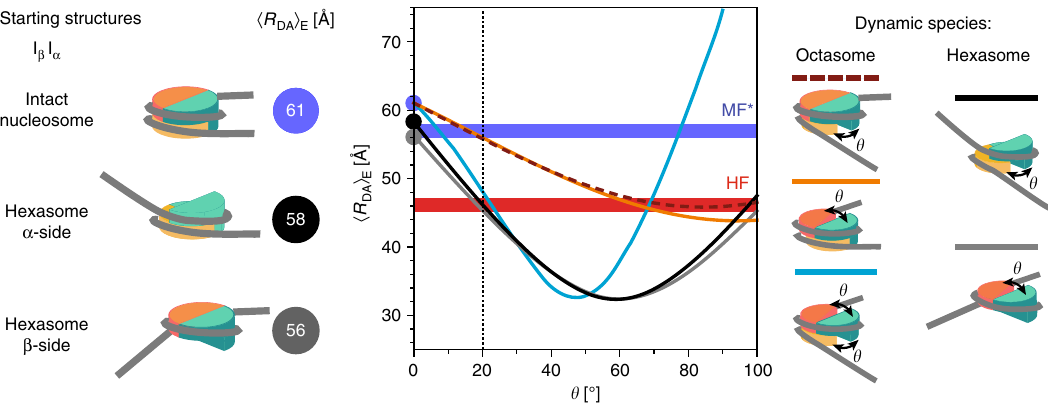
Fig. 7 A geometric model for nucleosome dynamics. All details on the parameterization of the intact nucleosome and de fi nitions of relevant parameters and the computer code are given in Supplementary Note 3. The (H3-H4) 2 tetramer is shown in turquoise, while H2A-H2B heterodimers are shown in orange ( α -side) and dark yellow ( β -side). The interdye distances 〈 R DA MF* 〉 E are computed for the following three starting structures (opening angle θ = 0°): the intact nucleosome and both possible hexasomes with an open α -side and β -side, respectively. We compute the geometry of potentially dynamic nucleosome species as a function of the opening angle θ (between the H2A-H2B dimer and the (H3-H4) 2 tetramer) for fi ve scenarios dimer:tetramer opening: (i, ii) intact nucleosomes (octasomes), where opening occurs either only on the α -side (orange line) or only on the β -side (wine dashed line), (iii) intact nucleosomes (octasomes) with simultaneous opening on both sides with equal angles (cyan line) and (iv, v) hexasomes that are missing the dimer at the α -side (black line) or at the β -side (gray line) with additional opening on the other so far closed side. The blue and red ribbons represent the ranges of experimentally determined average interdye distances for MF* ( 〈 R DA MF* 〉 E = (57 ± 1) Å) and HF ( 〈 R DA HF 〉 E = (46 ± 1) Å), respectively. Our model predicts an simultaneous and equal opening by ≈ 20° within a hexasome or an octasome, while rather unrealistic angles greater than 70° would be required for nucleosome species with only one open dimer:tetramer